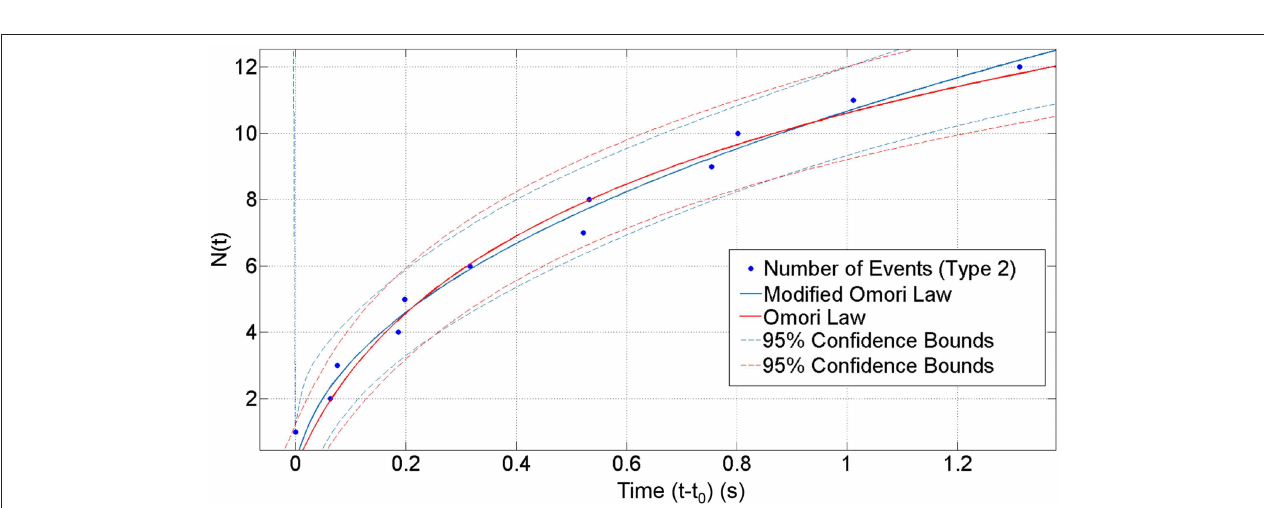
FIGURE 12 | Conventional and Modified Omori Law Fits of the cumulative number of events. The circles represent the cumulative number of events and the solid lines represent the fitting curves given by the Equations (5) and (7). t ′